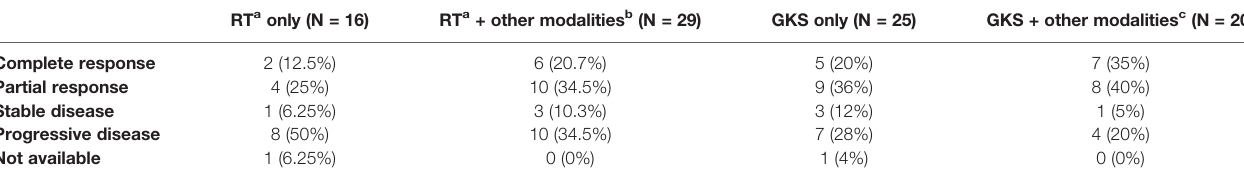
TABLE 4 | Responses rates of treatment of CNS